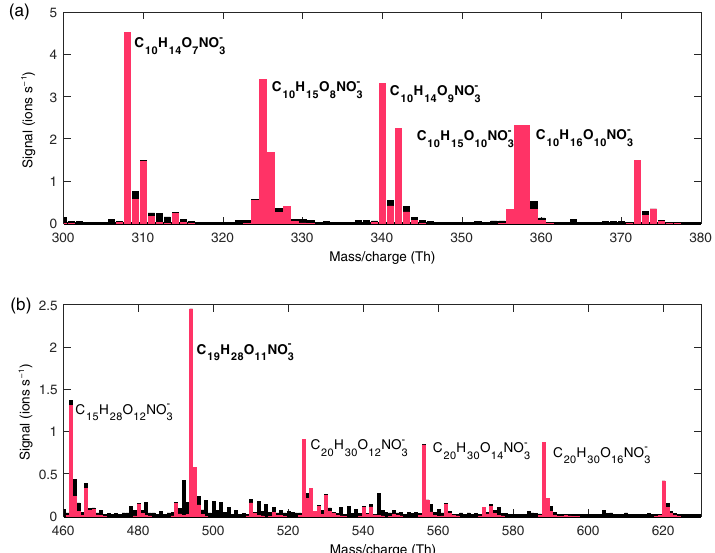
Figure 1. HOM mass spectrum during an α -pinene ozonolysis experiment (C10 compounds in panel a and C20 compounds in panel b ). The measured mass spectrum is depicted in black and the compounds identified as HOMs are depicted in red. The elemental composition of the compounds with the highest concentrations are shown in the figure and the six most abundant compounds are labelled in bold.